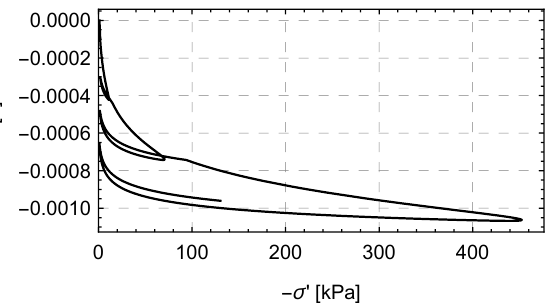
Figure 11. Relationship between σ (cid:48) and strain produced by the model for η = 20 MPa · min.